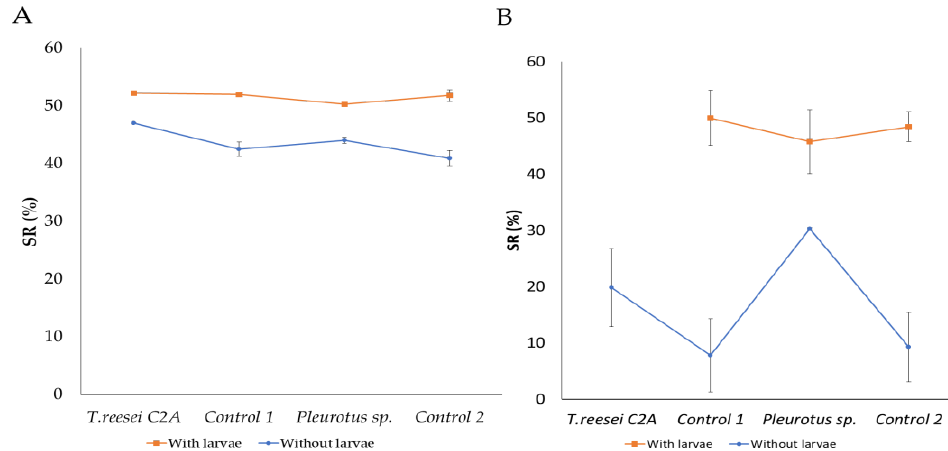
Figure 1. Substrate reduction (SR) of ( A ) non-sterilized and ( B ) sterilized BSG, after pretreatments with T. reesei C2A and Pleurotus sp., and H. illucens larva cultivation. Symbols represent the mean ( n = 3) and error bars the standard deviation of the mean (Tukey test, p < 0.0001). Control 1 and 2: BSG without inoculation of